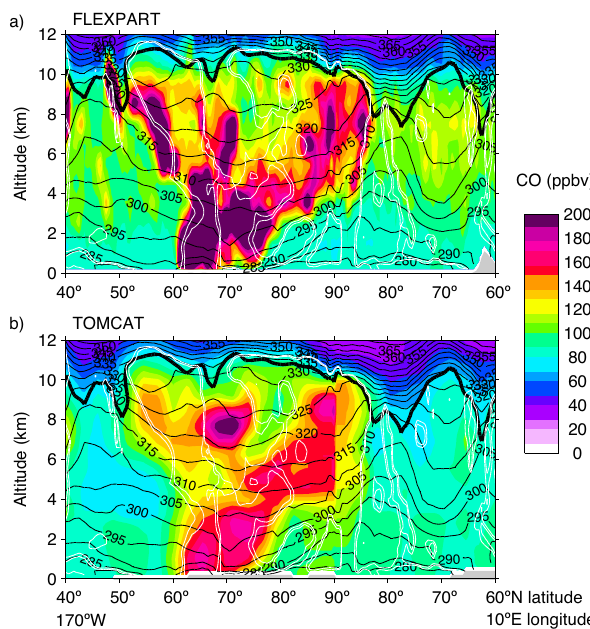
Fig. 5. As Fig. 3, but for a vertical cross-sections through the Arctic atmosphere on 8 July 2008 12:00UTC from 60 ◦ N to 40 ◦ N along 170 ◦ W/10 ◦